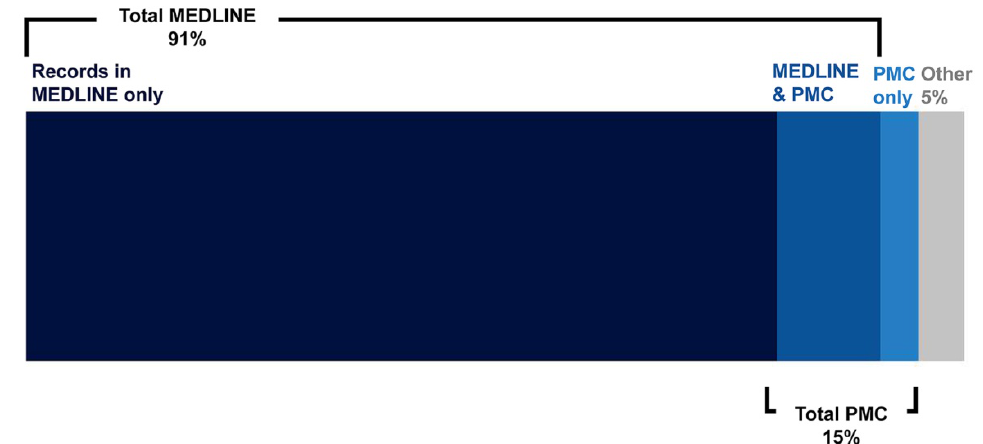
Figure 1 Composition of PubMed in